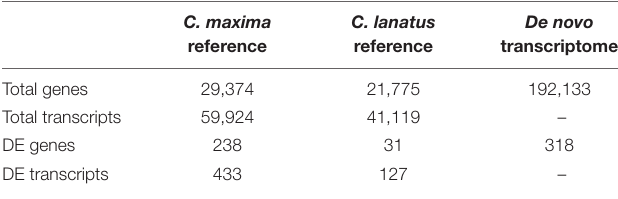
TABLE 2 | Discovered genes and transcripts with “New Tuxedo” protocols of the three comparisons.